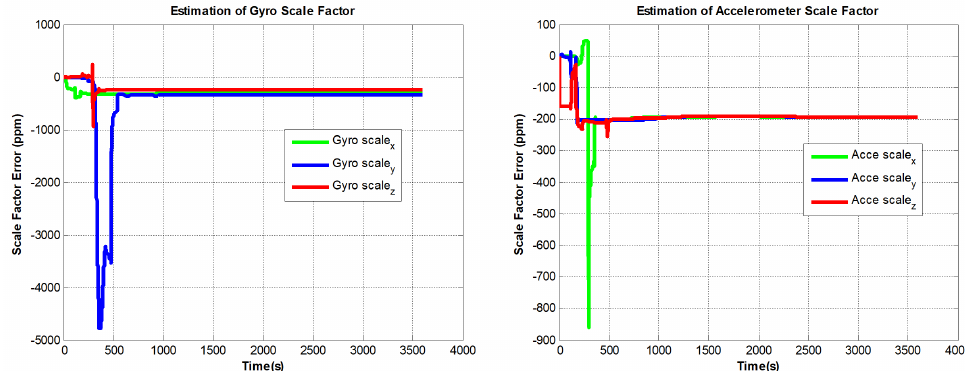
Figure 8. PIGA-based IMU scale factors estimation curves.